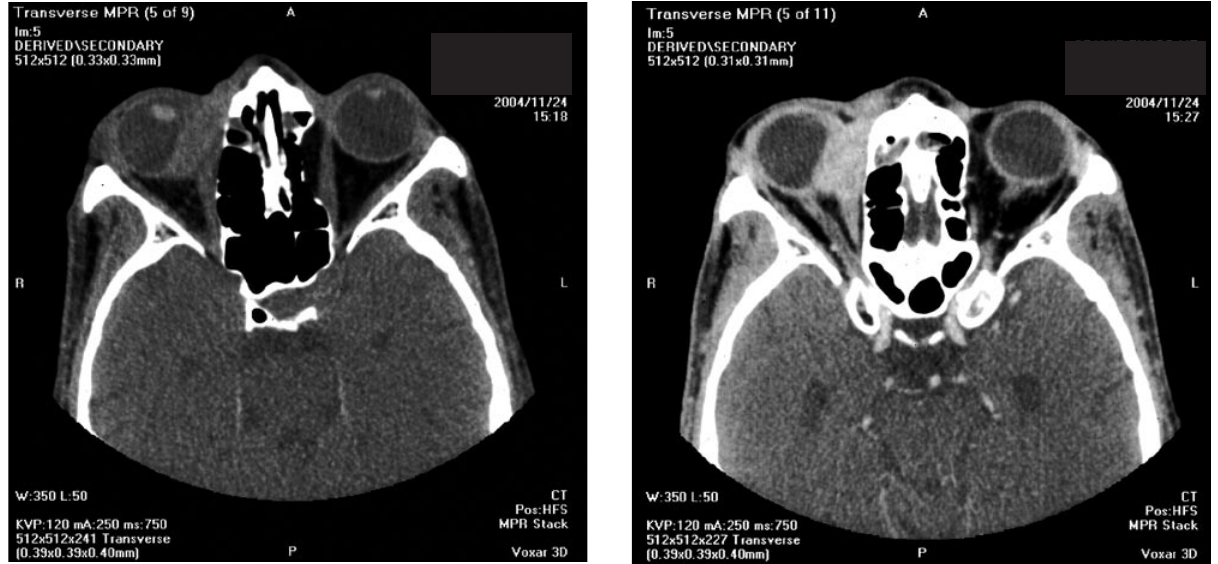
Figure 3. Computed tomography scans of eyeball and